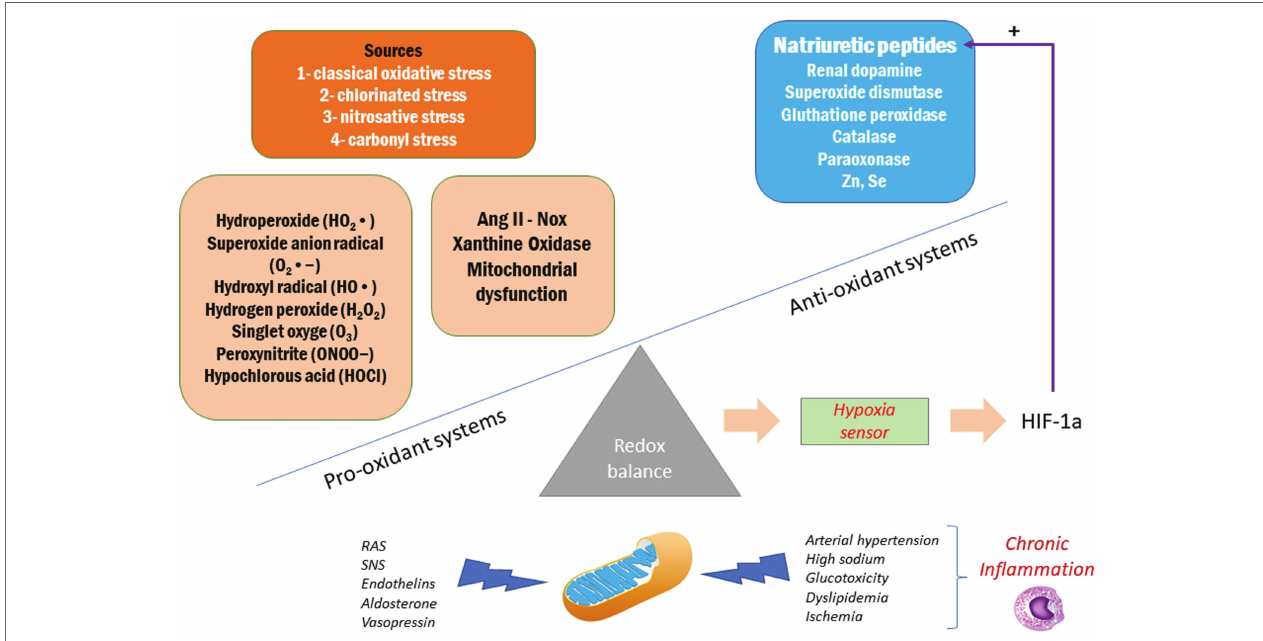
FIGURE 2 | Oxidative stress in the progression of chronic kidney